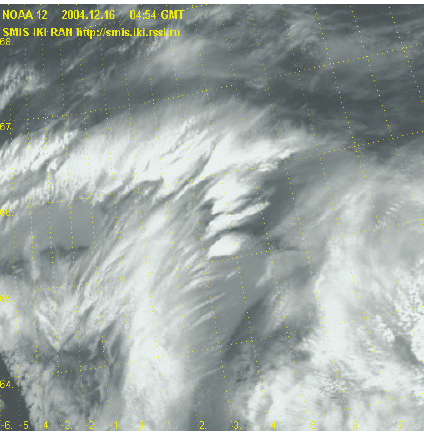
Figure 5: The fragment of regional cloud cover distribution data over the part of Norwegian Sea, derived from the results of satellite radiometer monitoring of the Earth’s atmosphere, obtained on December 16, 2004 at 04:54 GMT. Geographical coordinates are depicted on the horizontal and vertical axes.